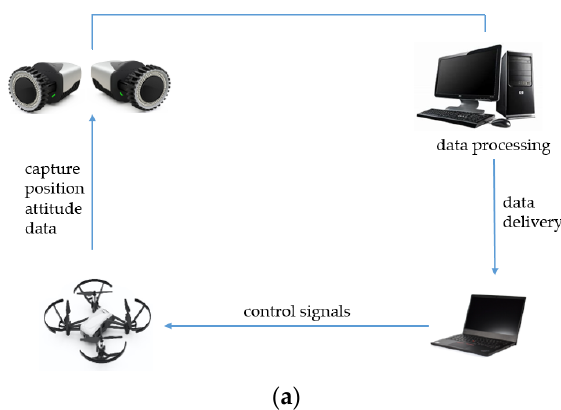
Figure 9. Quadrotor experimental environment. ( a ) Experimental equipment and control loop and ( b ) experimental field.